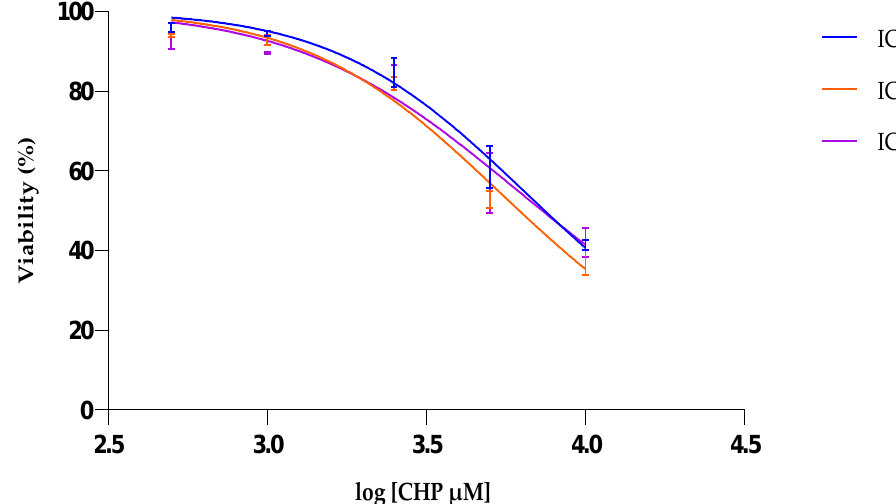
Figure 8. Flow cytometric assay of CHP cytotoxicity to E. coli strains IC188, IC203 and IC5233. The curves represent the % of live cells versus the logarithm of the concentration. Results are mean ± SD (n = 3).